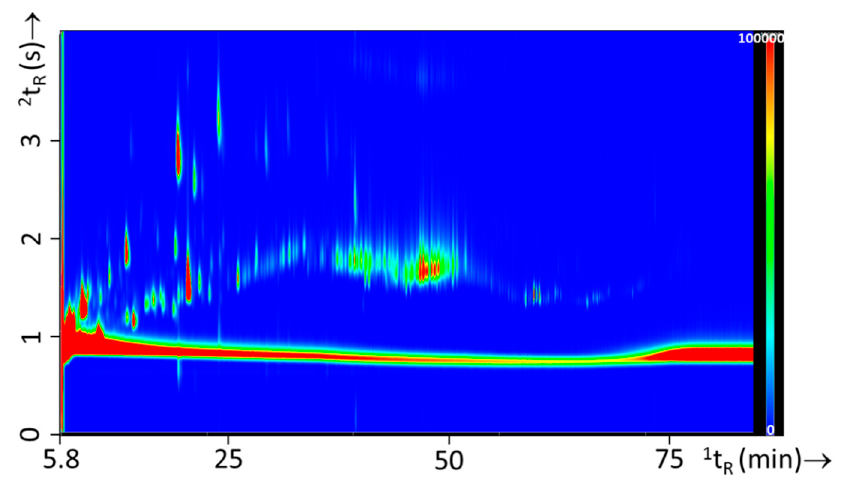
Figure 7. GC × GC-TOFMS TIC contour plot of a substrate mixture (experiment 24) containing carpet